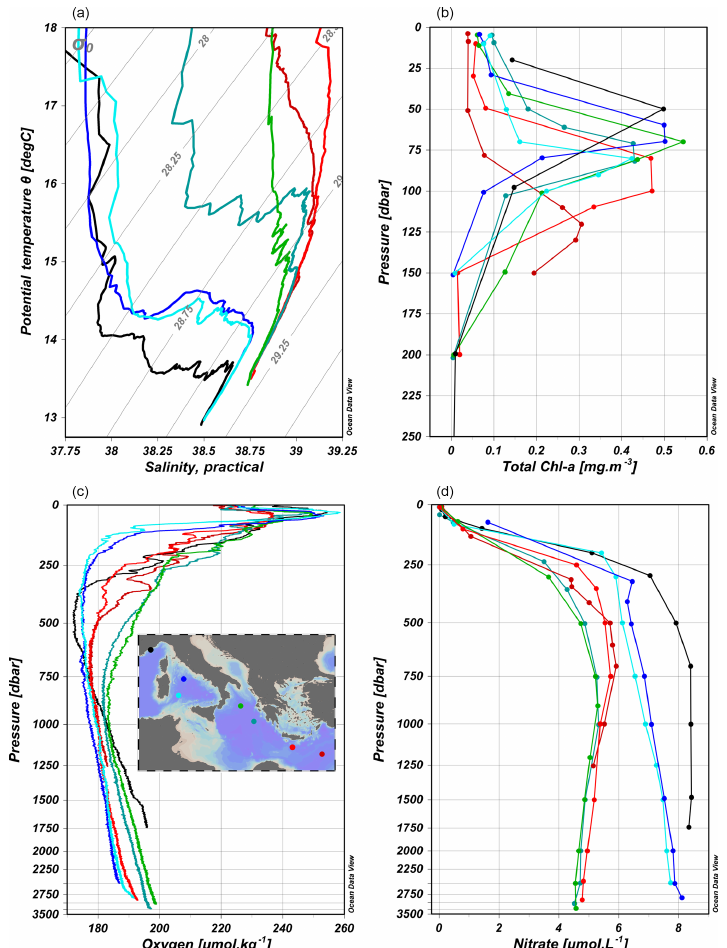
Figure 4. TS diagram comprised of CTD data (a) ; total chlorophyll a concentration profiles by HPLC method (b) ; dissolved oxygen concentration profiles from CTD data (c) ; nitrate concentration profiles by colorimetric method (d) . The inner panel shows the locations of CTD